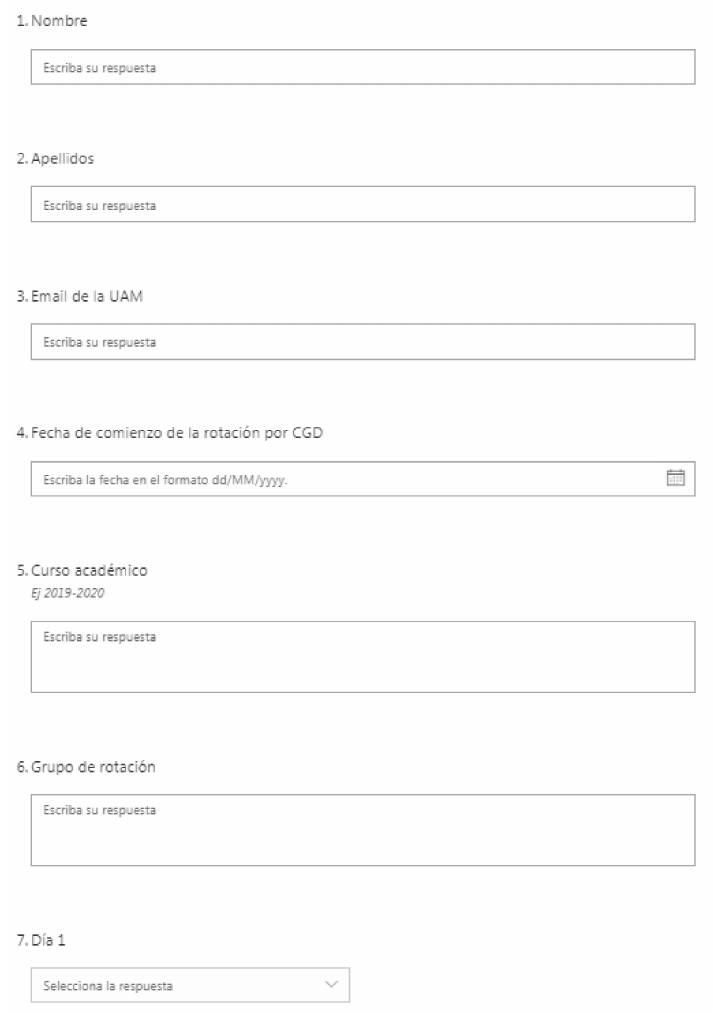
Figure 1. Form generated through Microsoft Office to collect the data per student related to the ro- tation through an excel spreadsheet to start substituting the checkerboards. Note: The names of the variables are Name, Surname, UAM email, Starting date of the rotation, Year in the degree in 2019–2020, Group of rotation, Day 1,